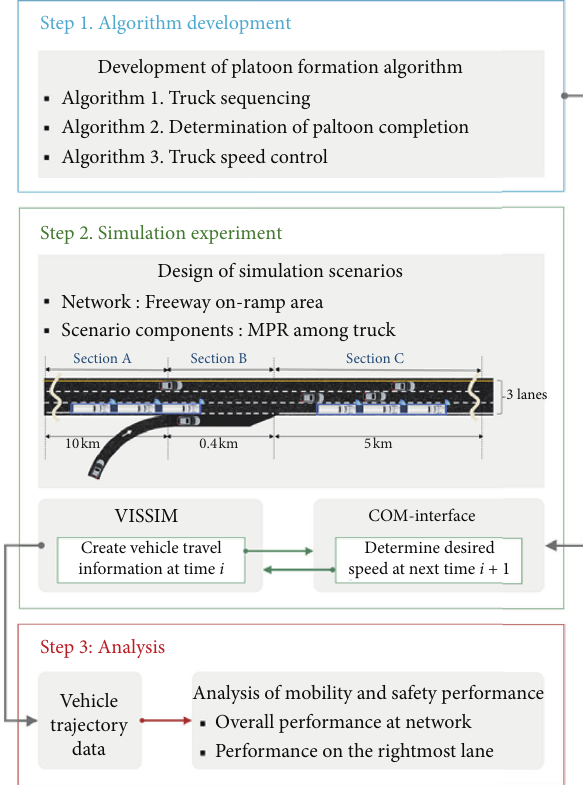
Figure 1: Overall